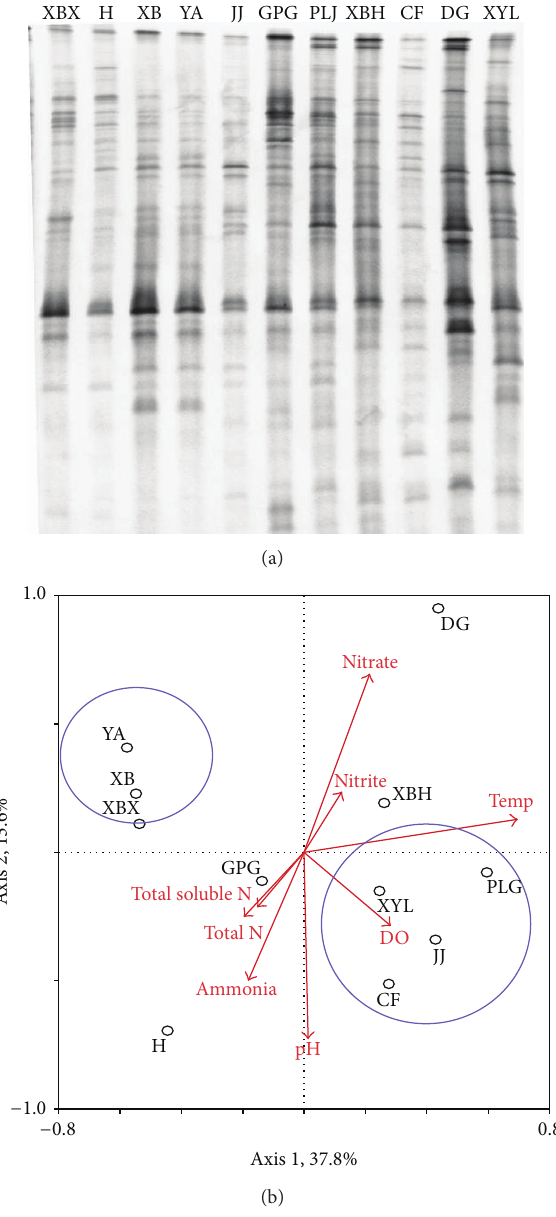
Figure6:DGGEfingerprintsandtheredundancyanalysisofDGGE band data of nosZ gene. Arrows represent quantitative variables of environmental variables and small circles with letters represent the name of sample rivers; river names: XBX = Xinbaoxiang, DG = Daguang, CF = Chuangfang, PLJ = Panlongjiang, H = Haiheriver, GPG = Guangpugou, JJ = Jinjia, XBH = Xibahe, XYL = Xinyunling, XB = Xiaba, and YA =